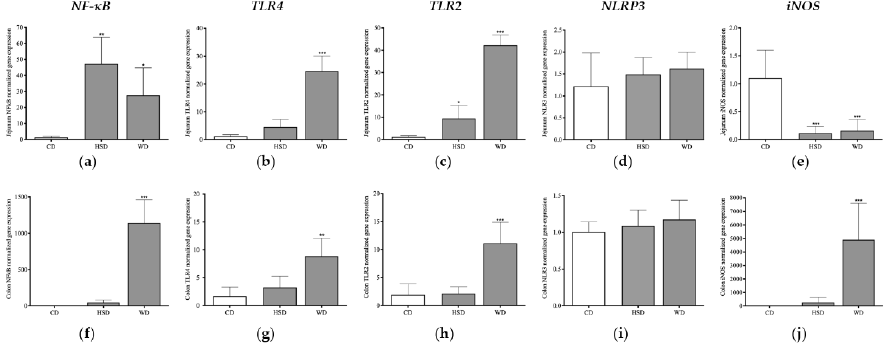
Figure 6. Graphic representation of the normalized expression levels of chow-fed diet (CD), high-sugar diet (HSD), and Western diet (WD), concerning NF-kB , TLR4 , TLR2 , NLRP3 , and iNOS genes in jejunum ( a – e ) and colon ( f – j ) samples. Expression levels were normalized against the respective 18S rRNA gene expression and then against the respective controls (CD), set as 1. Mean values ± standard deviation (SD) are plotted. *** p < 0.001, ** p < 0.01, * p < 0.05.